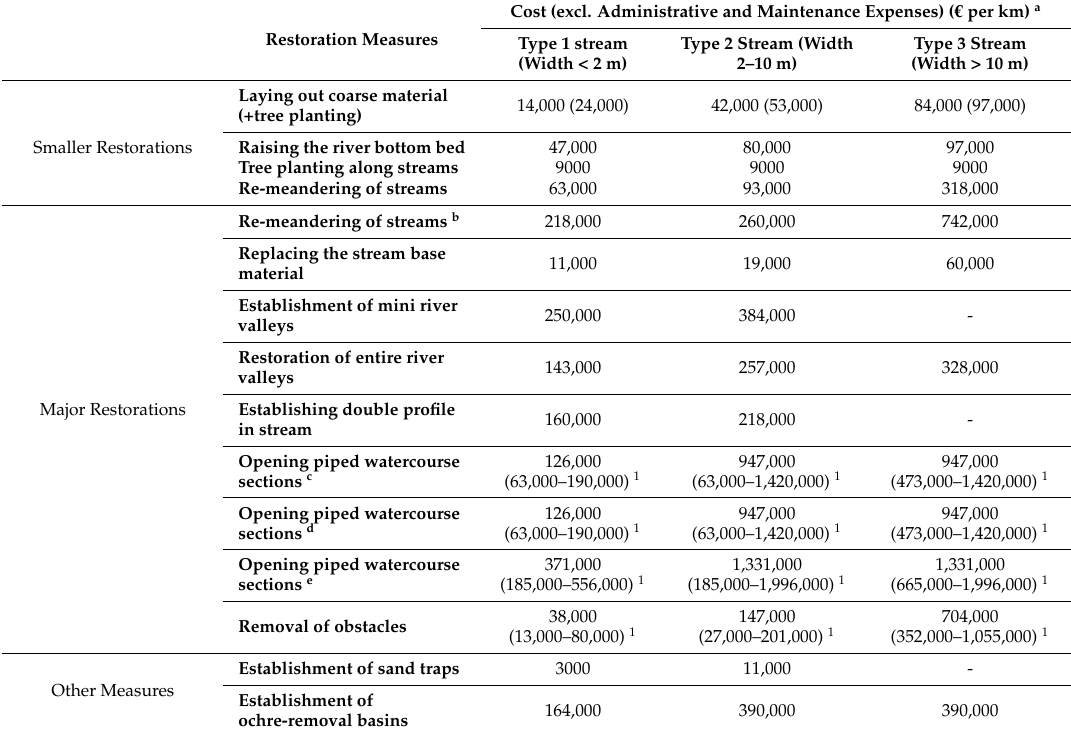
Table 1. Presentation of the 16 stream restoration measures and their respective costs, modified after